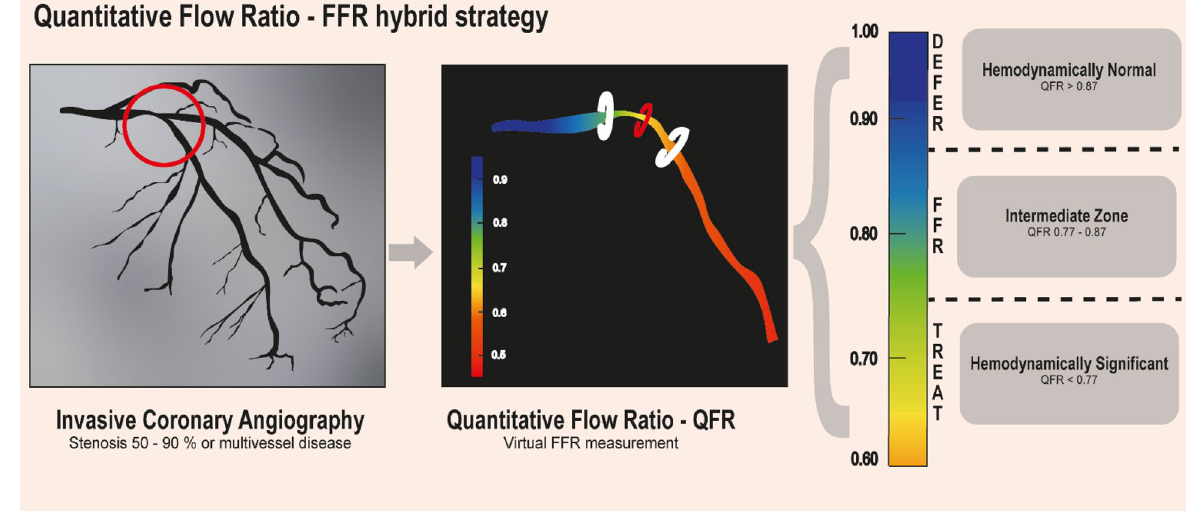
Figure 1. Study overview QFR – FFR hybrid strategy. All 50–90% stenosis or multivessel disease on invasive coronary angiography are assessed by QFR using dedicated software (QAngio XA 3D 1.1, Medis Medical Imaging System, Leiden, The Netherlands). Based on the QFR-value, lesions are categorized into hemodynamically normal (QFR > 0.87), intermediate zone (QFR between 0.77 and 0.87) or hemodynamically significant (QFR < 0.77). Only lesions in the intermediate zone are further assessed by FFR. In our population, this leads to a reduction of invasive FFR measurements of 56.7%. FFR fractional flow reserve, QFR quantitative flow